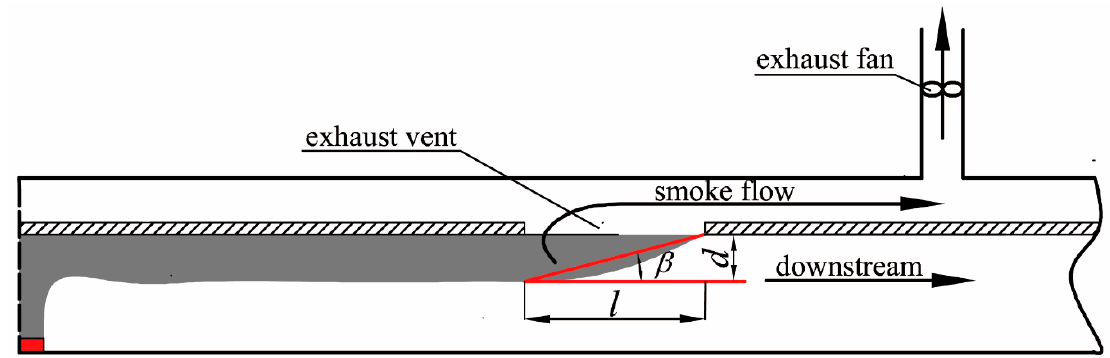
Figure 12. Schematic diagram of inclined angle β .